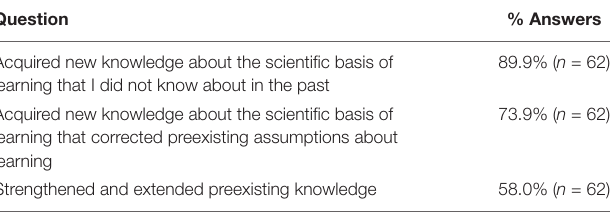
TABLE 3 | Knowledge acquisition by teachers after participating in the seminar. Question % Answers